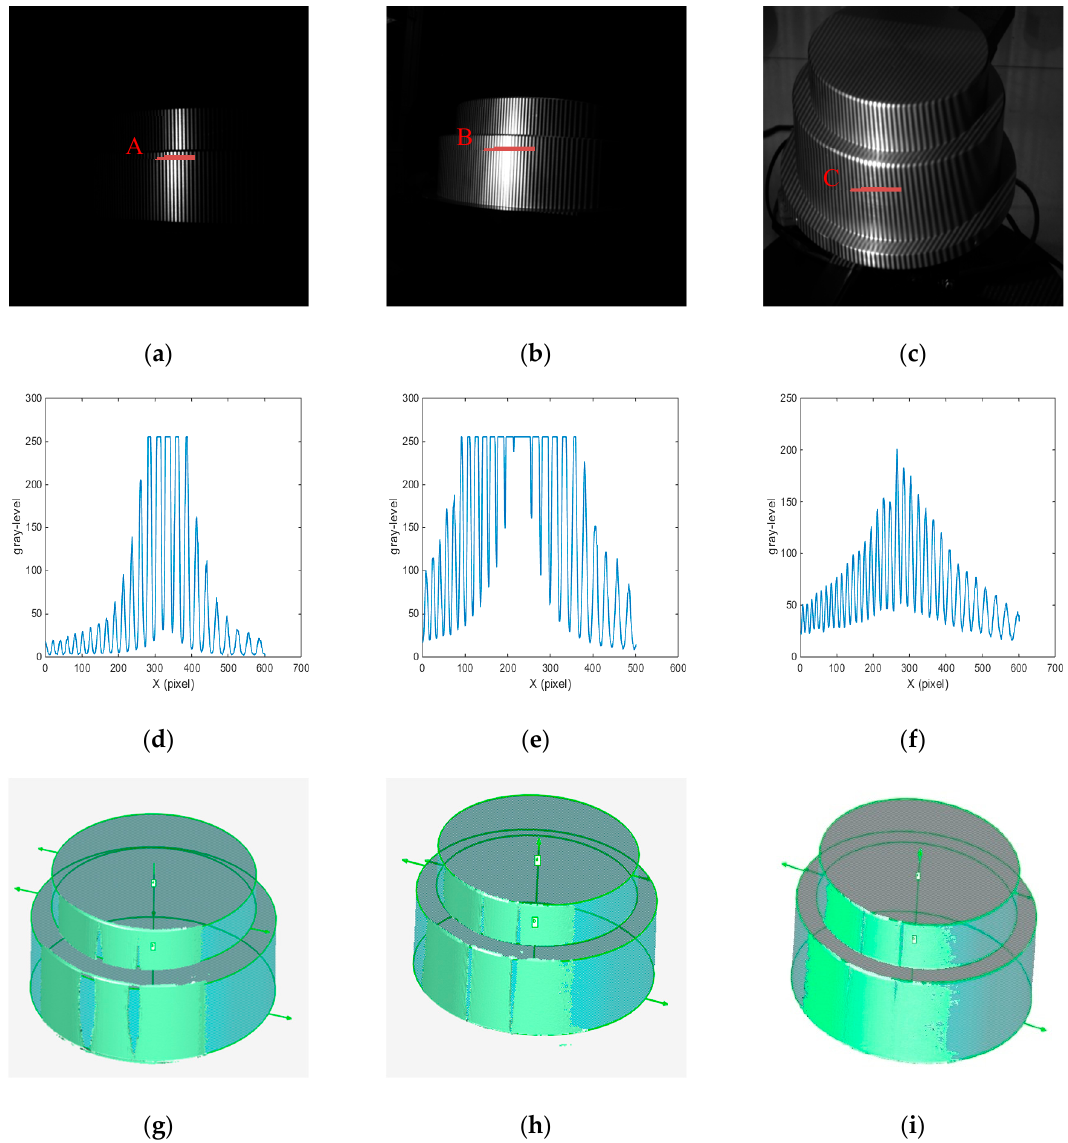
Figure 11. Measurement effect of stepped cylinder object. ( a ) Fringe image with FPP method, ( b ) fringe image with adaptive method, ( c ) vertical fringe image with ABFDP method, ( d ) fringe curve of A, ( e ) fringe curve of B, ( f ) fringe curve of C, ( g ) point cloud of cylinders with FPP method, ( h ) point cloud of cylinders with adaptive method, ( i ) point cloud of cylinders with ABFDP method.